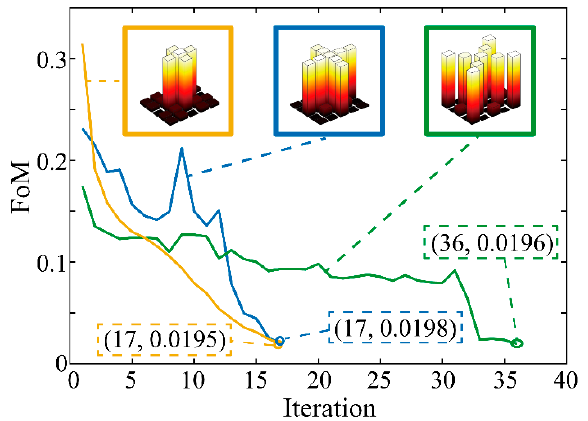
Figure 3. FoM as a function of the iteration in the optimization of beam splitters with tailored